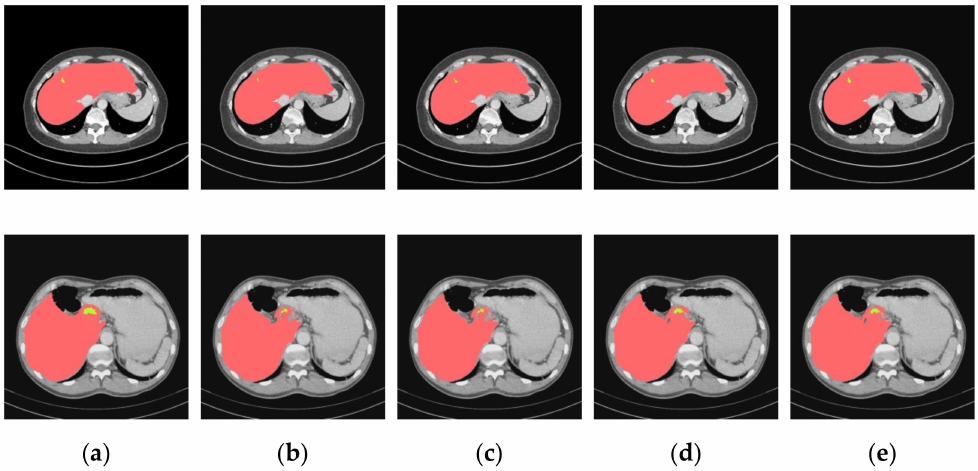
Figure 7. Segmentation results for the liver and tumors of pattern two. ( a ) Ground truths, ( b ) U-Net,